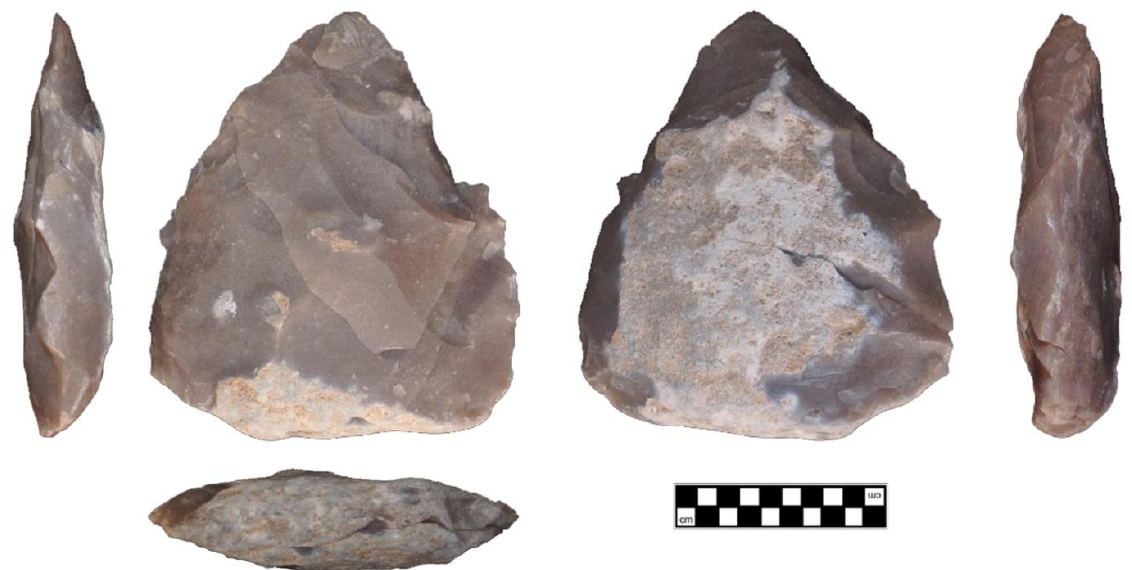
Figure 3. Replica 2 roughed-out biface blank 3.1. Flake 1 - Overshot flake